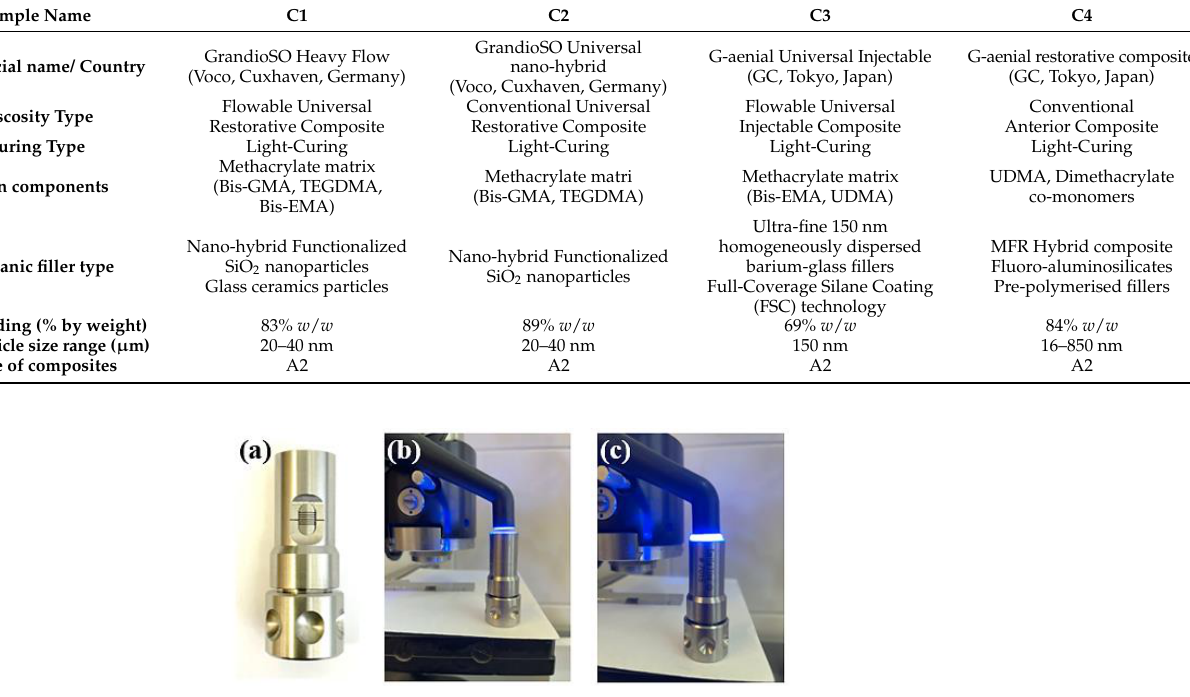
Table 1. Characteristics of the resin-based composite dental filling materials (Flowable vs. Con- ventional) included in the study.